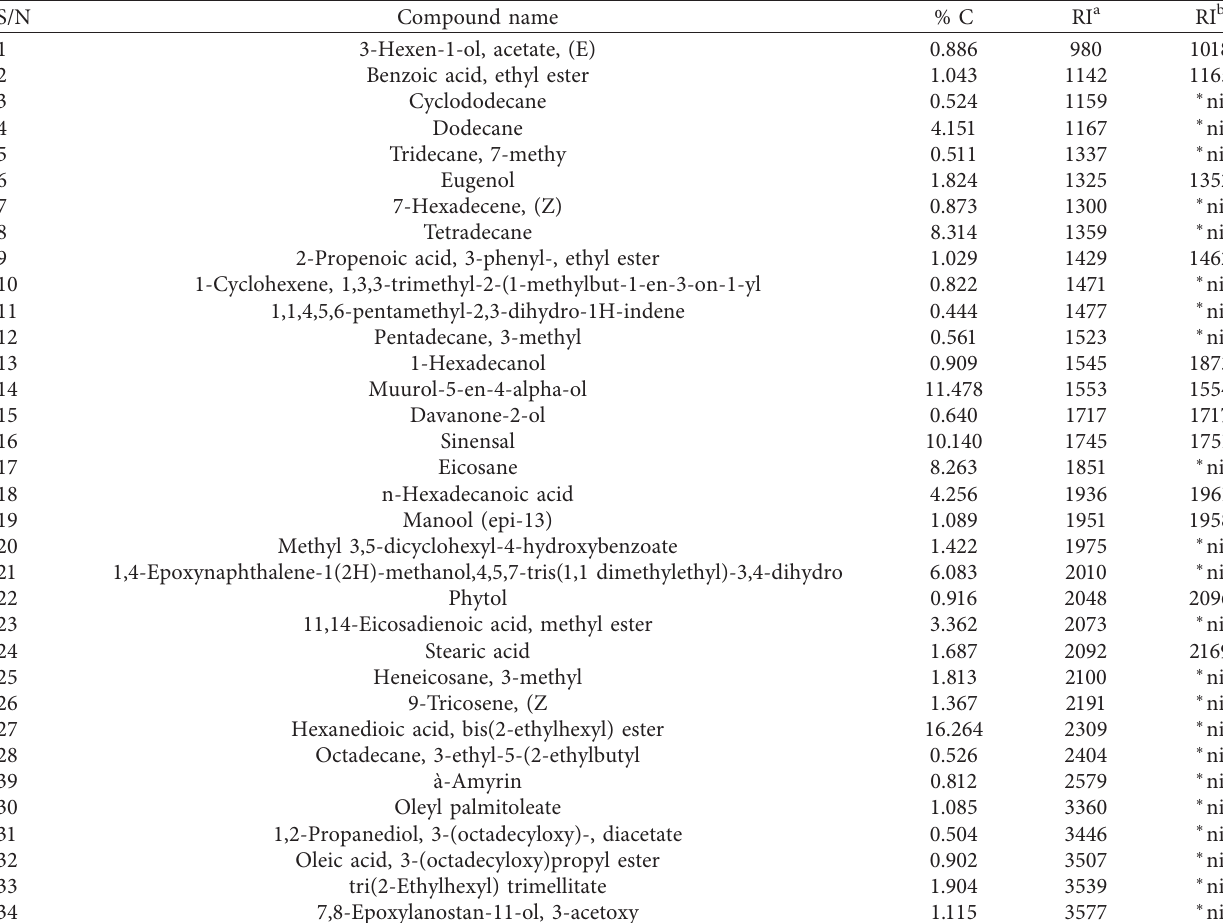
Table 2: Fruit essential oil composition of Chrysophyllum albidum as determined by GC-MS.